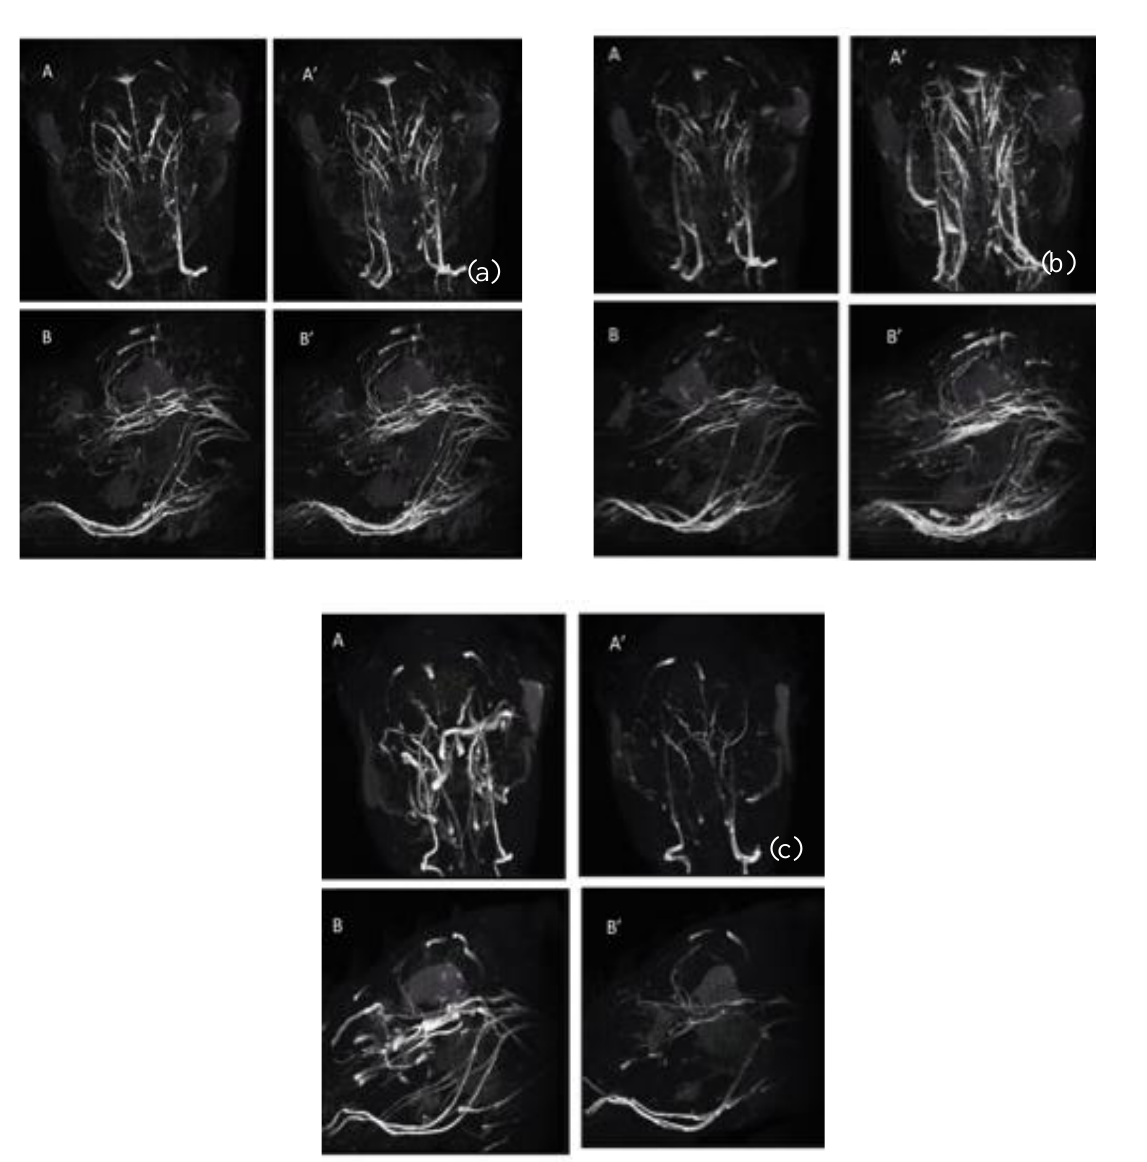
Figure 14. MRA with TOF 3D in vivo demsontrated in rat brain. Images from maximum intensity projection (MIP) are shown, where A and A ’ represents a slice of MIP with and without contrast agents at 3 ◦ from the horizontal position, B and B ’ represents with and without contrast agents at the sagittal position for the nanoparticle size of ( a ) 6 nm, ( b ) 10 nm, and ( c ) 15 nm.